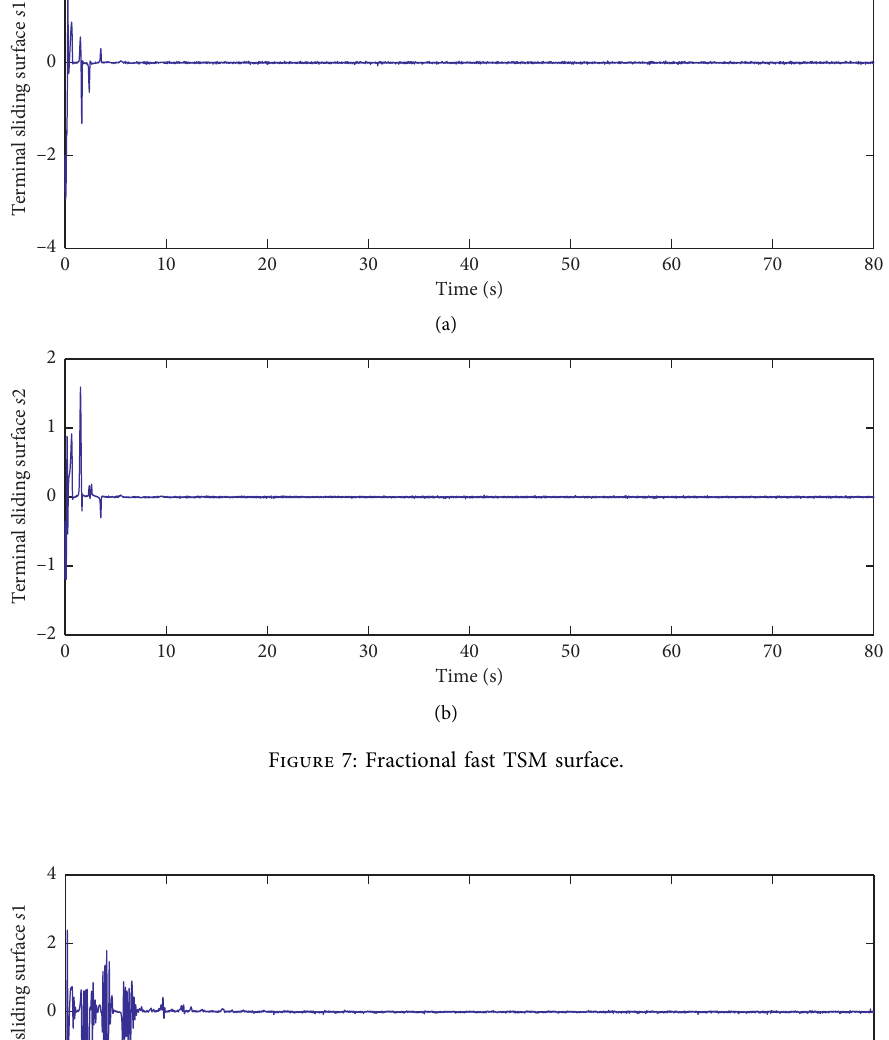
Figure 7: Fractional fast TSM surface.